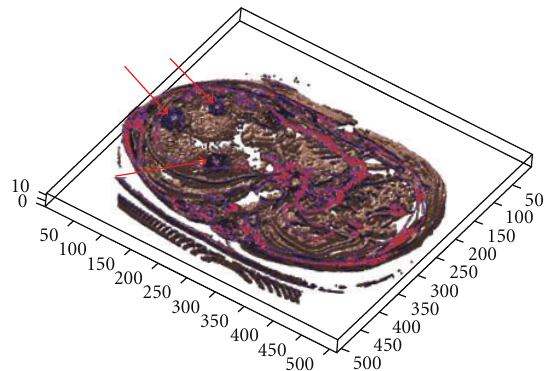
Figure 25: Segmenting patient volume data a ff ected by the liver cancer (located by red